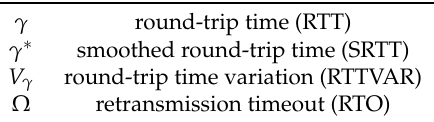
Table 1. Notations of Dynamic RTO in RFC